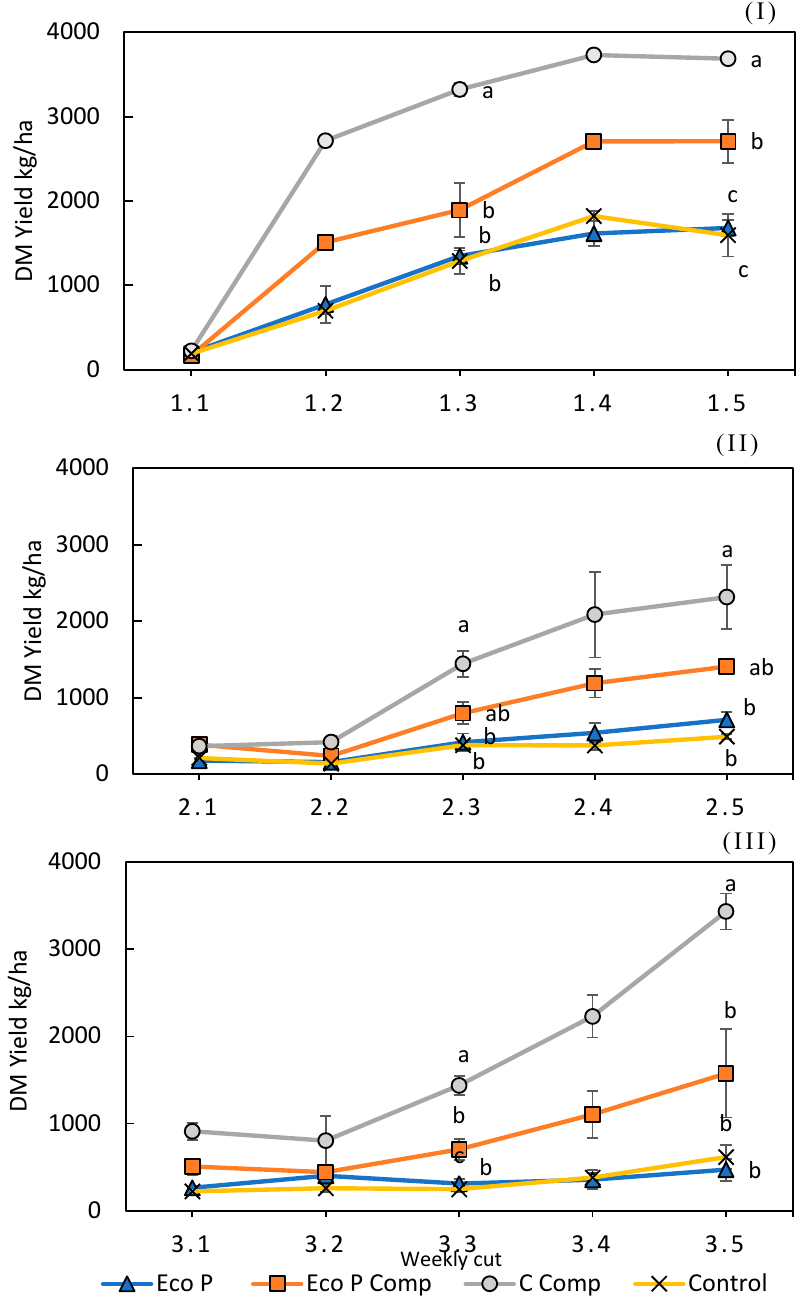
Figure 5. Third-year (2020) weekly growth measurements for inter harvest growth period one to three ( I – III ). Statistical analyse is presented for weeks 3 and 5, with no statistically significant difference occurring between treatment sharing the same letter ( p > 0.05); error bars indicate standard error.